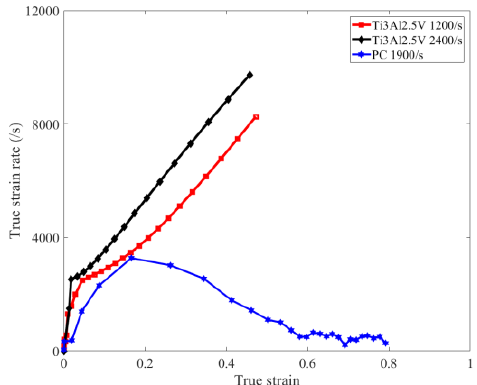
Fig.4 Local strain rate evolutions for two materials at high strain rates